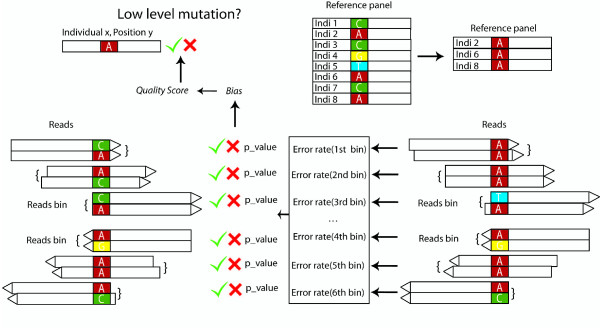
Workflow of the pipeline. For each position in the target region, samples having the same consensus nucleotide are used as reference samples. Reads are categorized into different bins according to their positions and orientation when mapped to the reference genome; reads mapped to the questioned sample are also assigned to the same set of bins. By comparing the minor allele count and expected error count, bins are divide into two categories: bins with minor allele count equal or less than the expected error (derived from the reference panel; denoted by a green check mark), and bins with minor allele count greater than the expected error (red cross). Different methods (Poisson, Fisher exact, Empirical) were used to calculate the P-value, which represents the deviation of the observation from expectation under the error model. The P-values are then used to calculate the bias statistic, which is further converted to a Phred-like quality score to represent the uncertainty concerning the minor allele at this position.